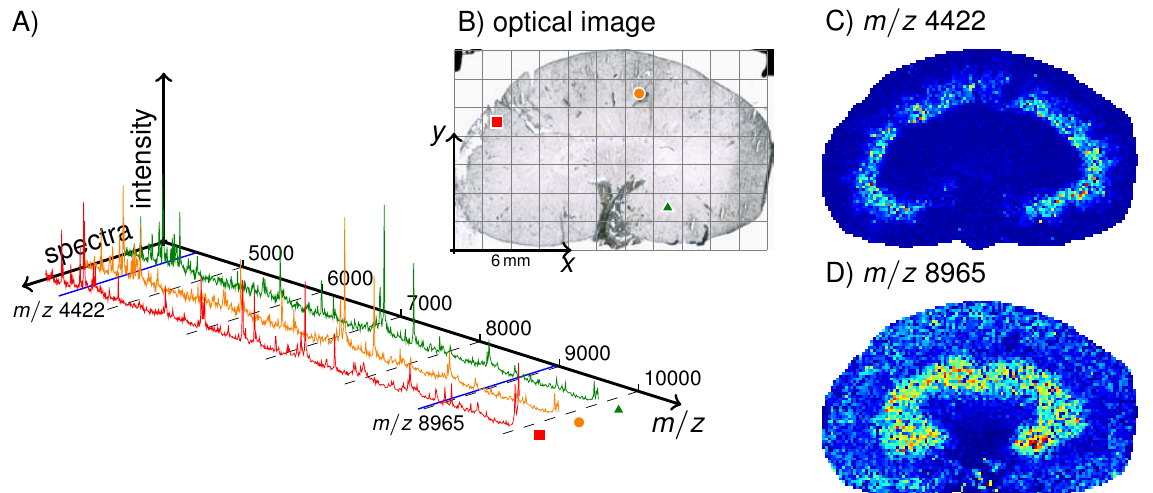
Figure 1: An MALDI-imaging data set is a data cube. Spectra (A) are measured at spatial points of a sample (B) with spatial coordinates (x,y). Given a mass (m/z value), one obtains an intensity image; examples for the channels m/z 4422 and m/z 8965 are shown in (C,